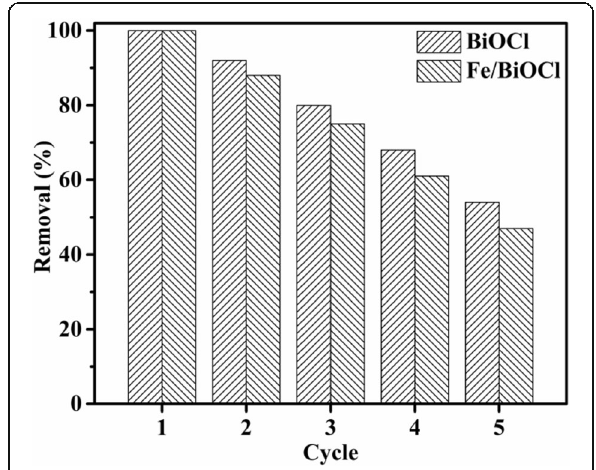
Fig. 13 The adsorption cycle tests of BiOCl and